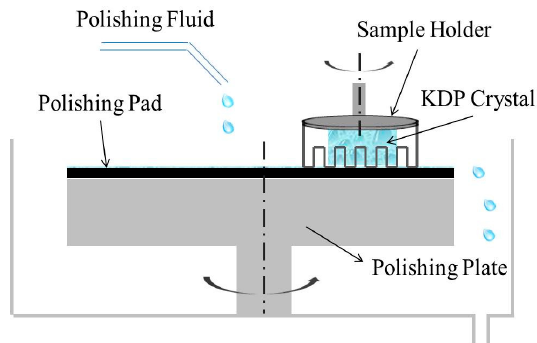
Figure 1. Schematic diagram of chemical mechanical polishing technology for KDP crystals.